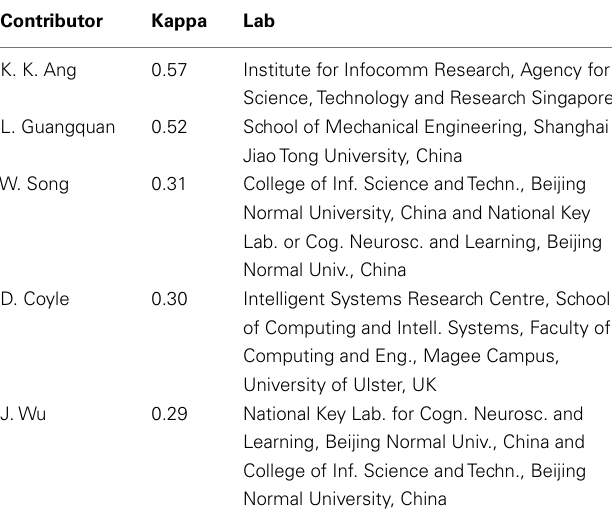
or linear regression (Schlögl et al., 2007a). The use of other cor- Table 3 | (Data Set 2a). Contributions with final result